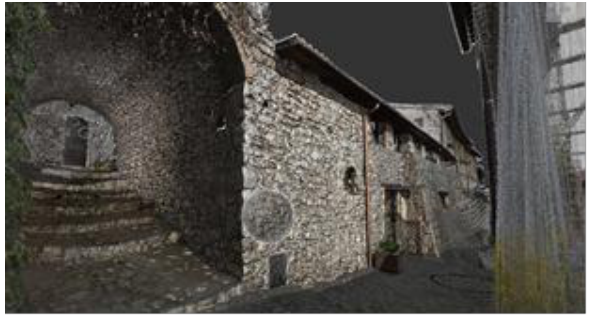
Figure 7. Recap view of the hamlet scan